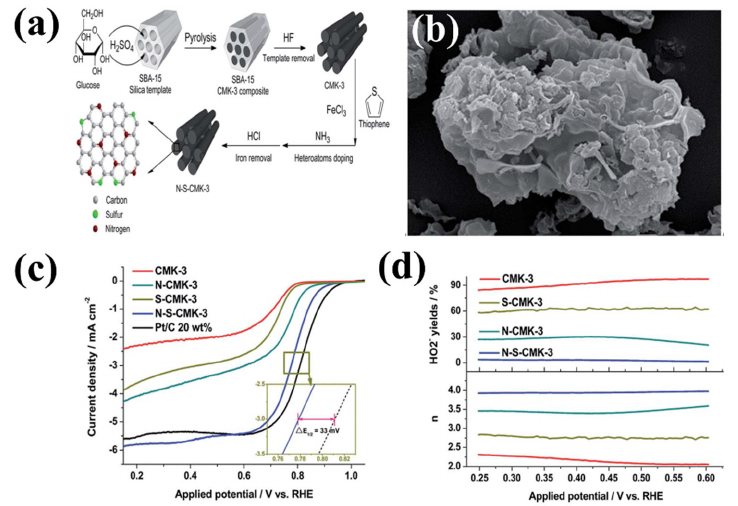
Figure 8. ( a ) Schematic of the synthesis of metal-free mesoporous N–S–CMK-3 catalysts, ( b ) SEM image of N–S–CMK–3 800 °C, ( c ) comparative polarization curves for different catalysts with the same loading measured at 1600 rpm in O 2 saturated 0.1 M KOH solution, ( d ) HO 2- yields (top) during the ORR and the corresponding electron transfer number ( n , bottom) of the prepared catalysts measured by RRDE, adapted from [61].